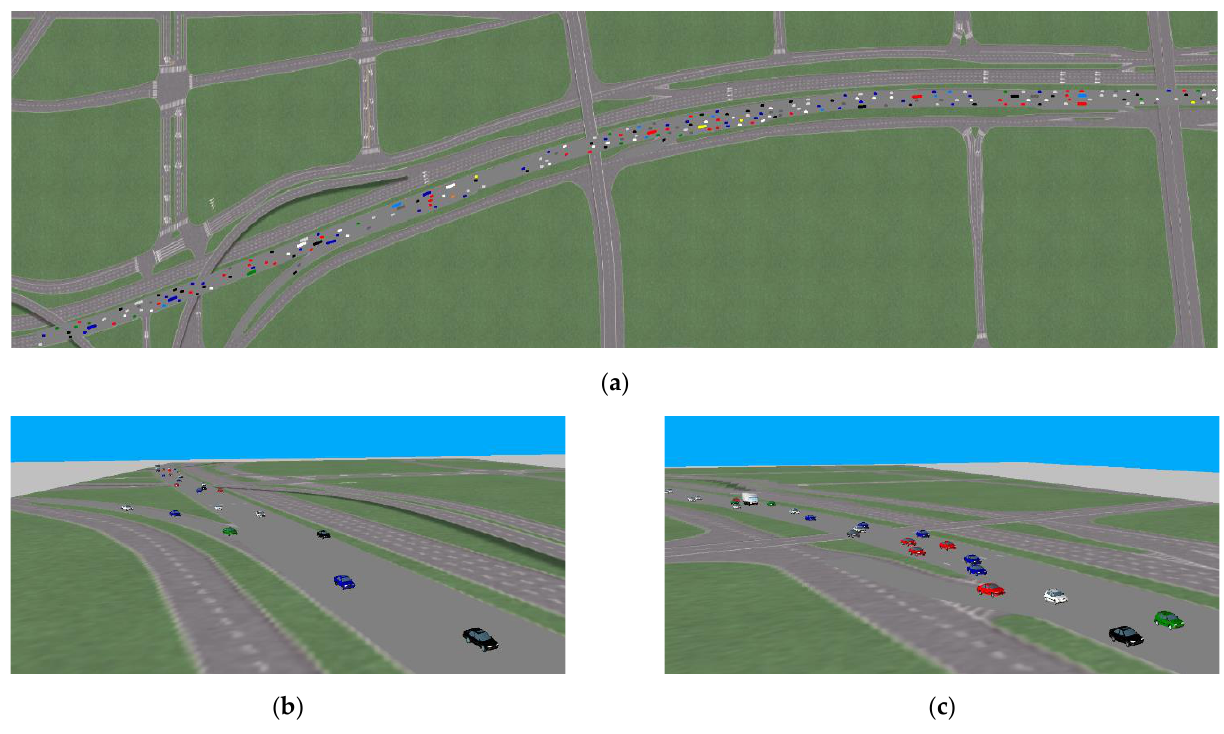
Figure 11. VISSIM simulation road sections. ( a ) Simulation interface; ( b ) Merging area 1; ( c ) Merging area 2.